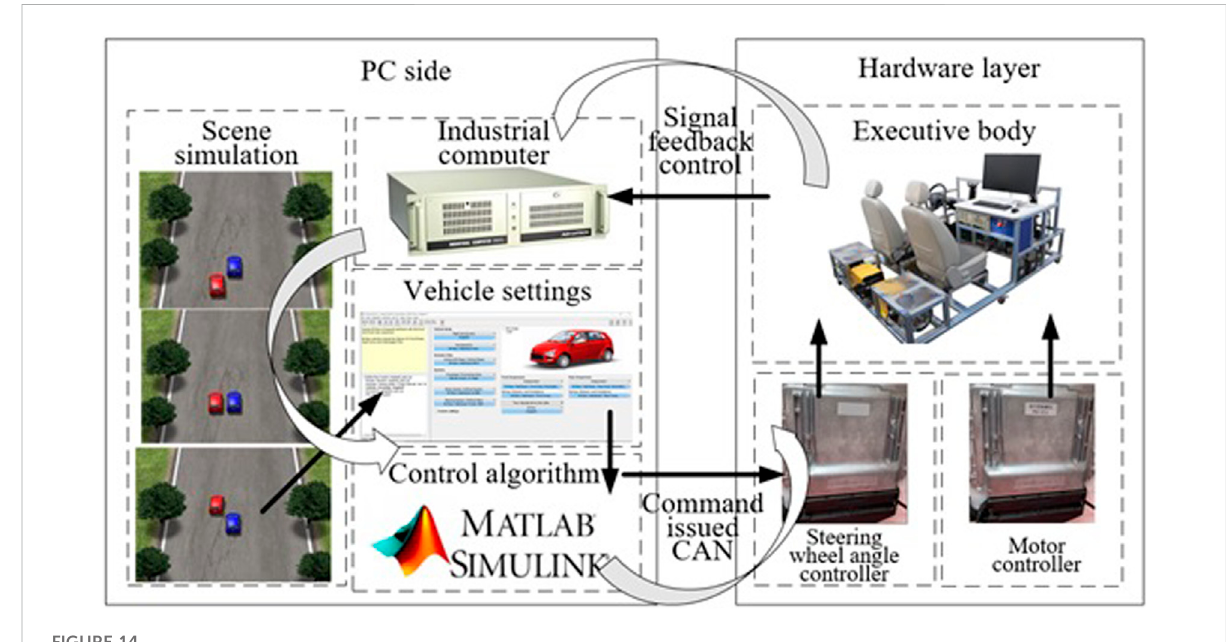
FIGURE 14 HIL test platform framework.